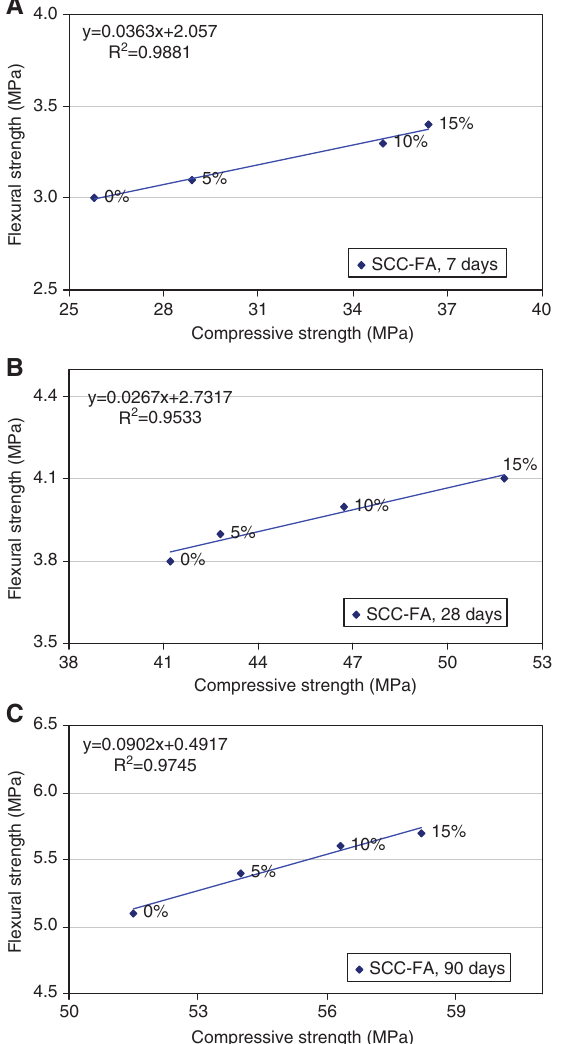
Figure 1 Flexural strength results of SCC-FA